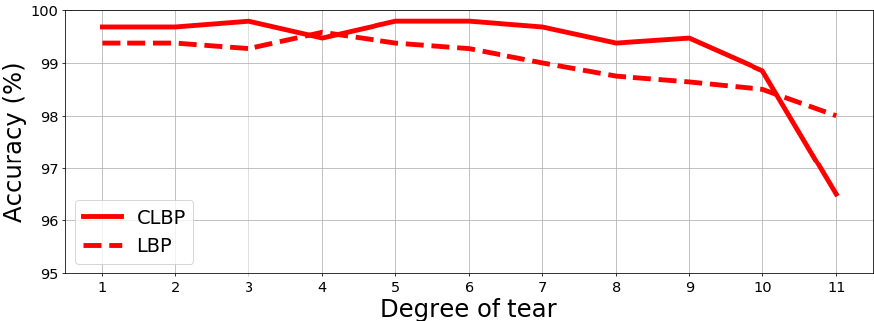
Figure 7. Accuracy employing CLB and LBP VS degrees of tear alteration.